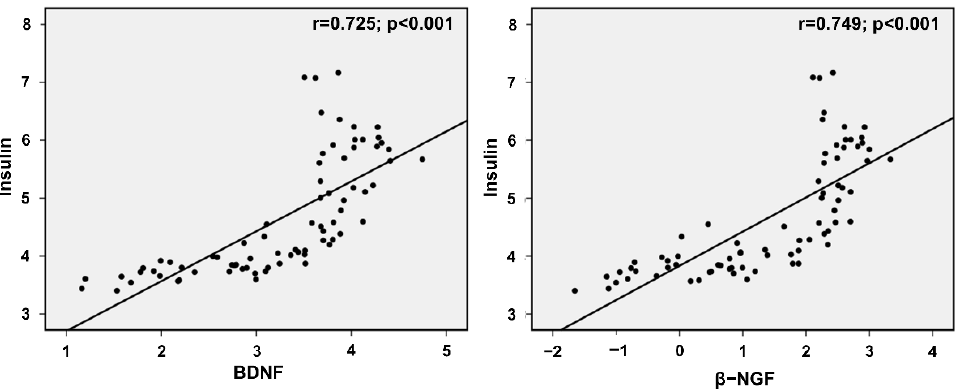
Figure 5. Correlation showed a significant association between insulin and neurotrophins BDNF and NGF. The results show r = 0.725 and r = 0.749, respectively.